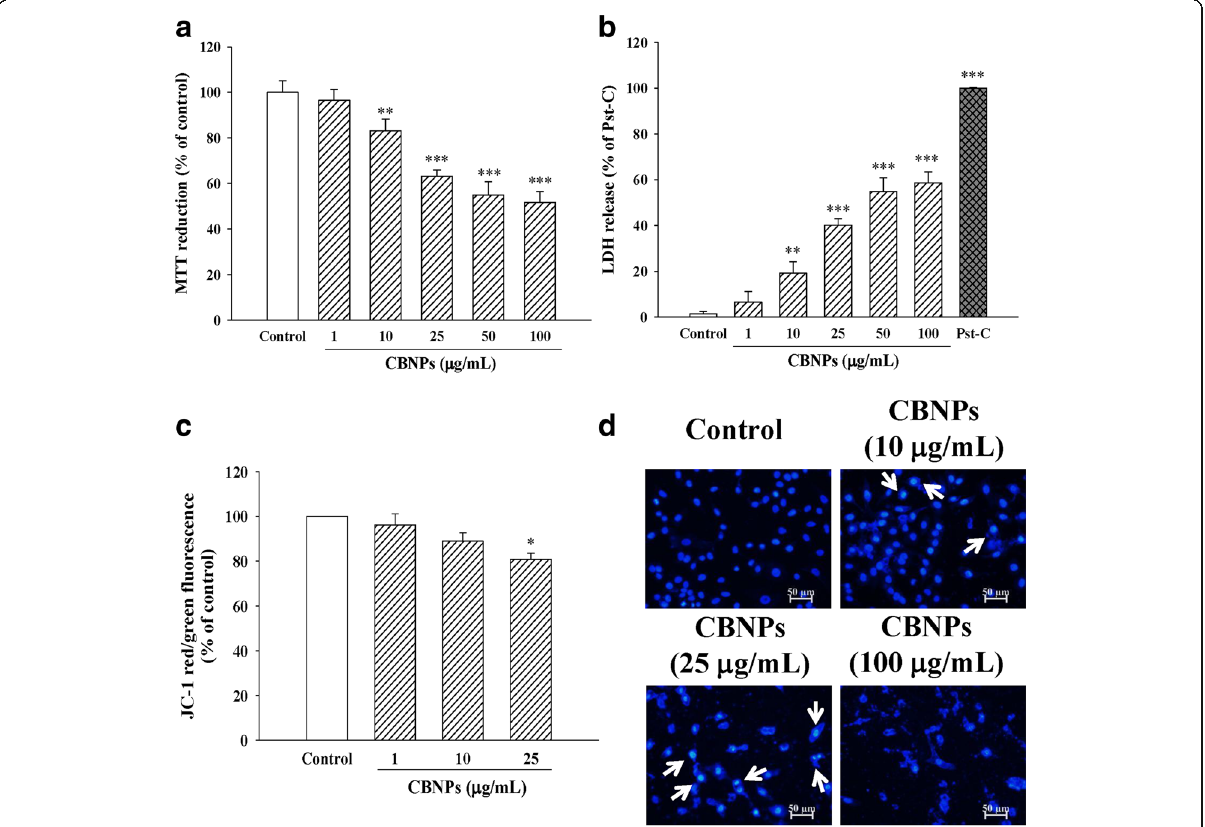
Fig. 1 Effects of CBNPs on cell viability assessed by MTT ( a ) and LDH ( b) assay, and on changes of mitochondrial membrane potential ( ΔΨ m) ( c ) and nuclear condensation ( d ) in A549 cells. ΔΨ m was measured by JC-1 staining and analyzed by a flow cytometer. Nuclear condensation (white arrow) was determined by Hoechst 33,342 and observed by a fluorescent microscope. Cells were treated with CBNPs for 24 h. Bars represent the mean ± S.E.M. from six independent experiments. * P < 0.05, ** P < 0.01, *** P < 0.001 vs. control group (without any treatment). Scale bar = 50 μ